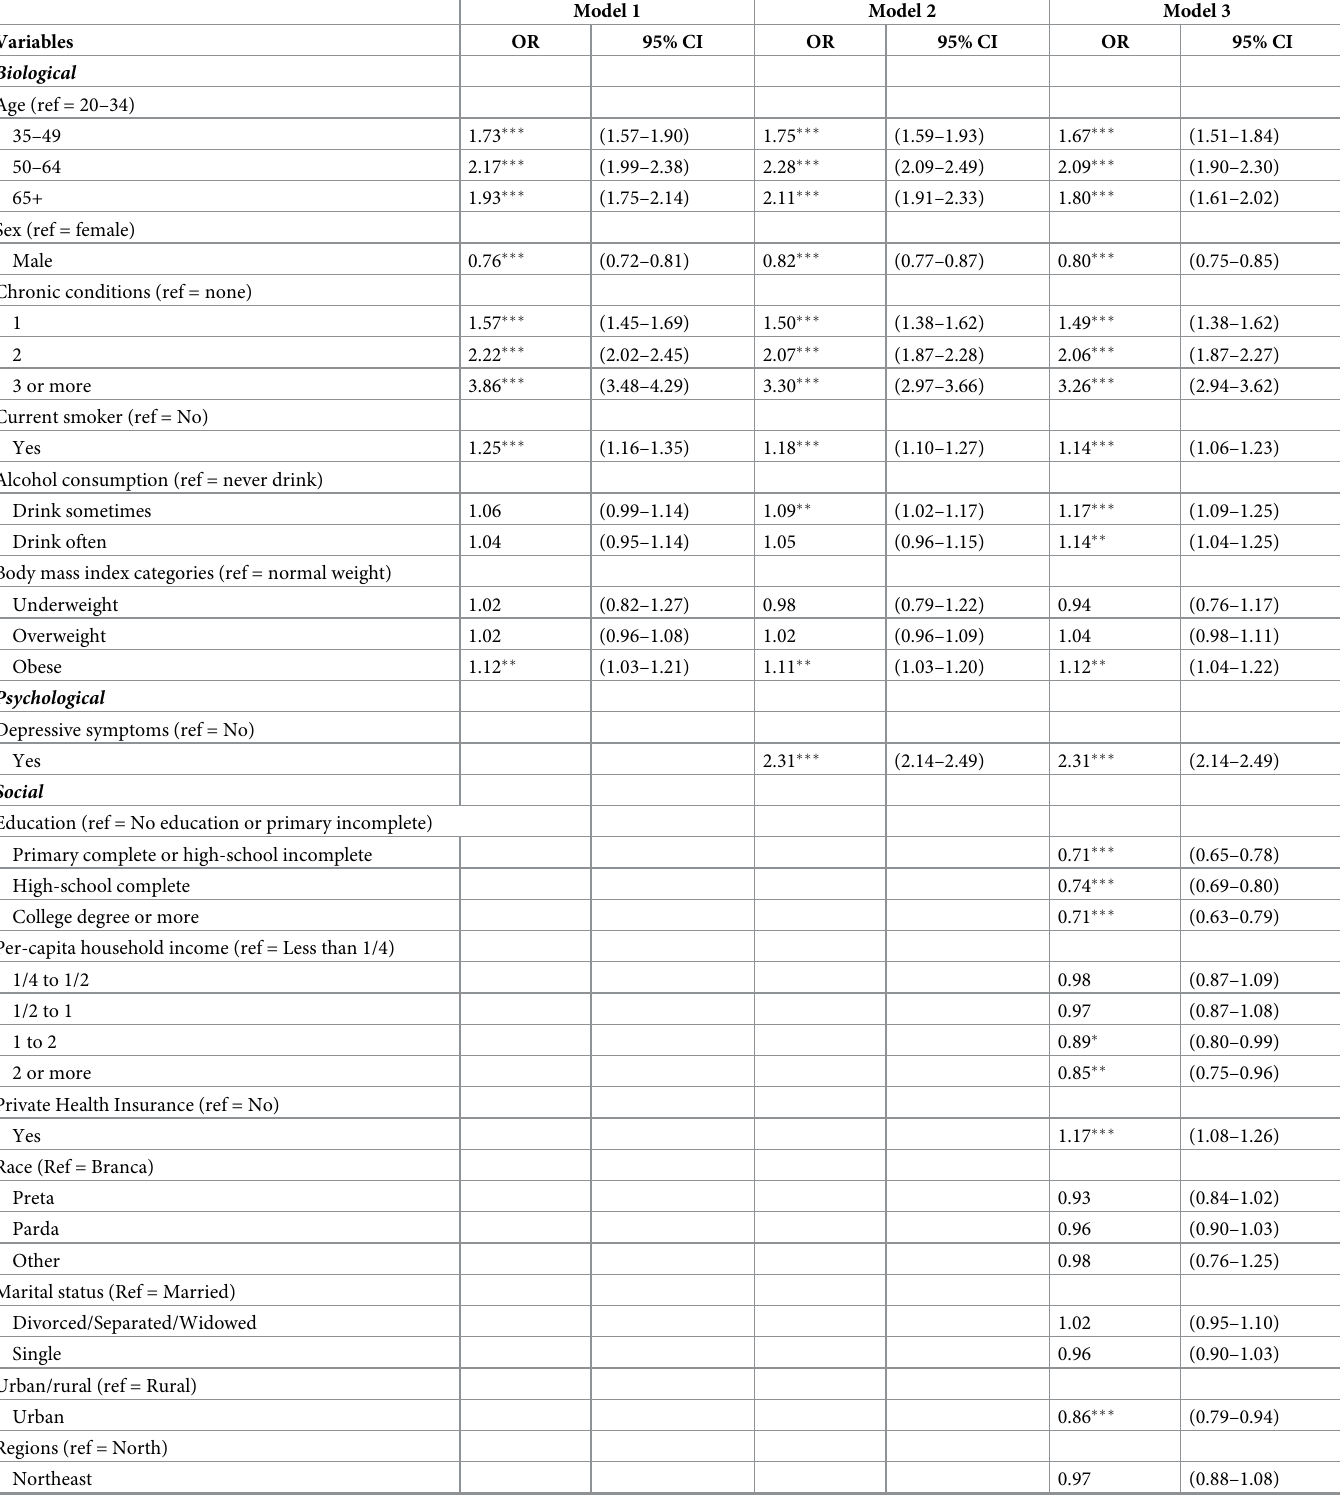
Table 3. Adjusted odds-ratios and 95% confidence intervals on the associations between reporting chronic back pain and biopsychosocial